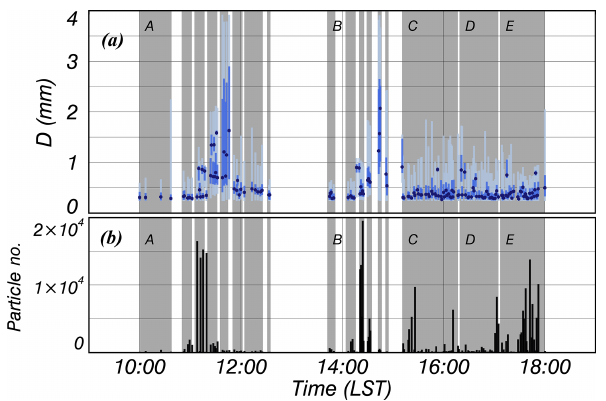
Figure 6. The 1min interval time series of D and the number of particles in the free-fall experiment conducted at the NIED.